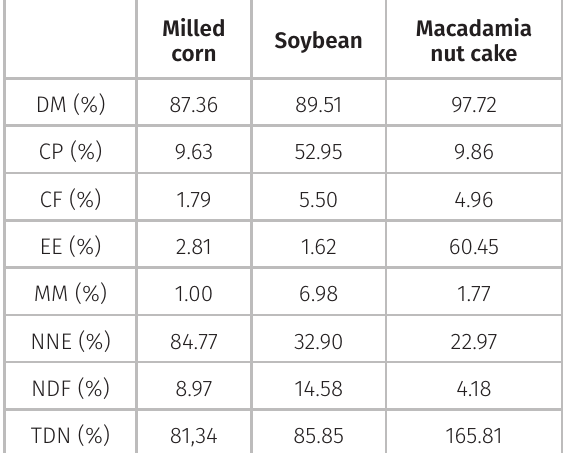
Table I. Chemical composition of the ingredients used in the experimental diets.